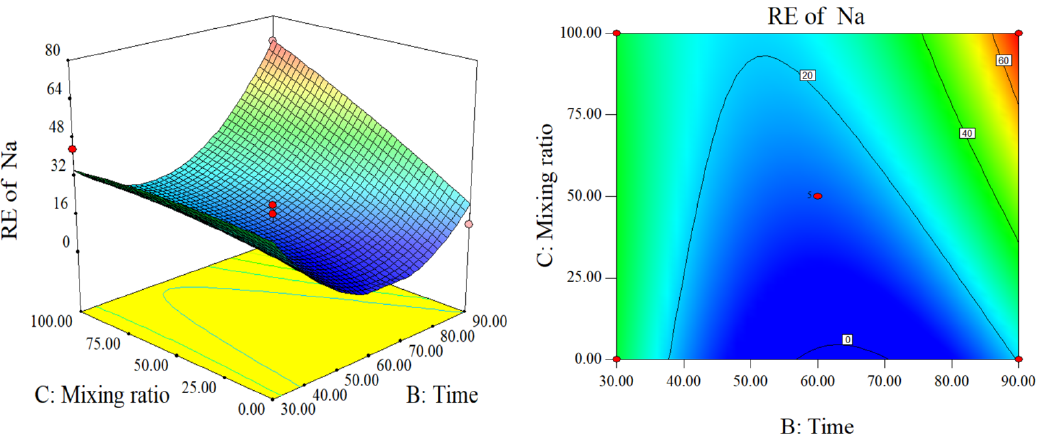
Figure 4. Response surface plots and contour plots of RE of Na.